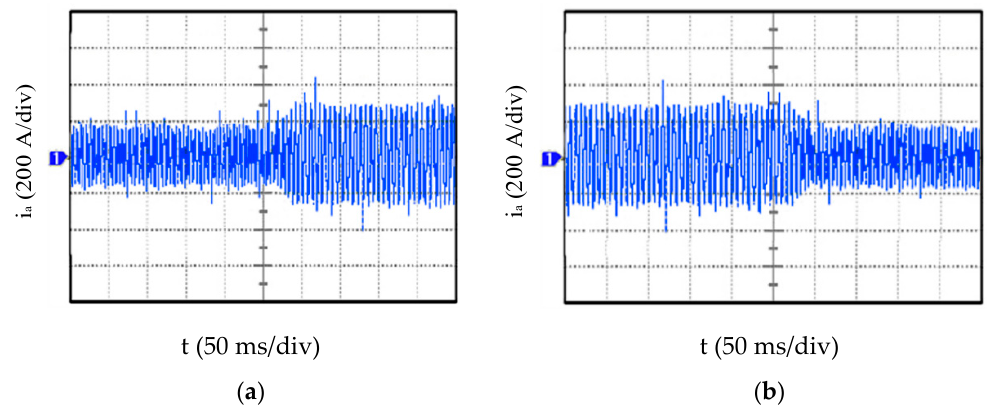
Figure 18. A-phase current waveform when load changes: ( a ) load decreases; ( b ) load increases.